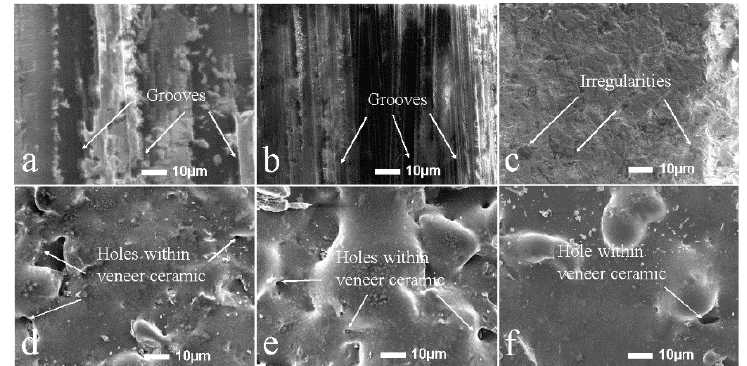
Figure 6. SEM (X500 magnifications) images show the topography of the core material following